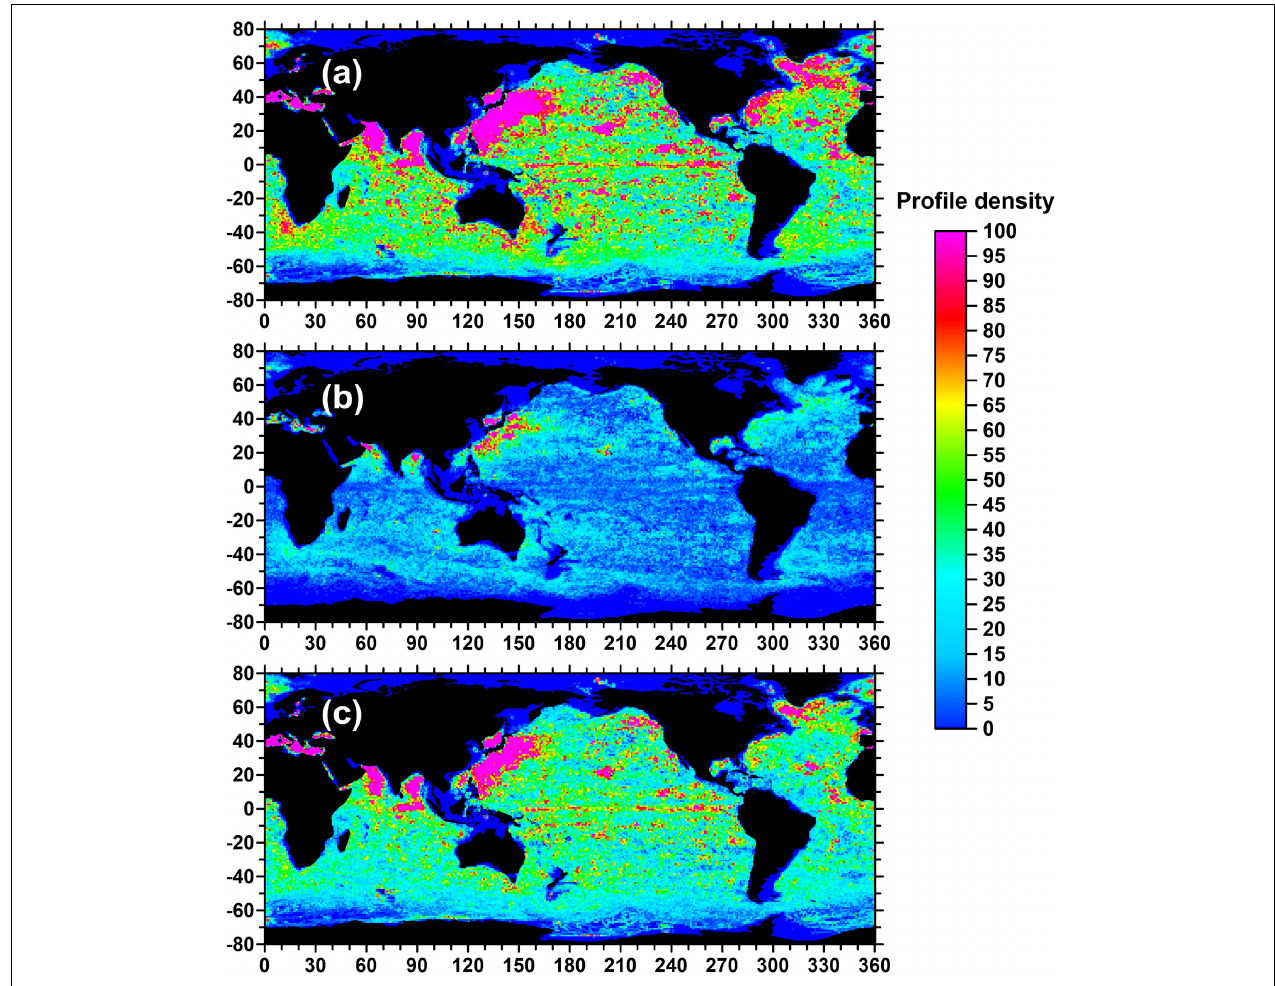
FIGURE 1 | Global geographic distribution of Argo profiles during 2002–2019 under 1 ◦ × 1 ◦ grid. (a–c) Cumulative number of all profiles, profiles inside Alt eddies, and profiles outside Alt eddies,